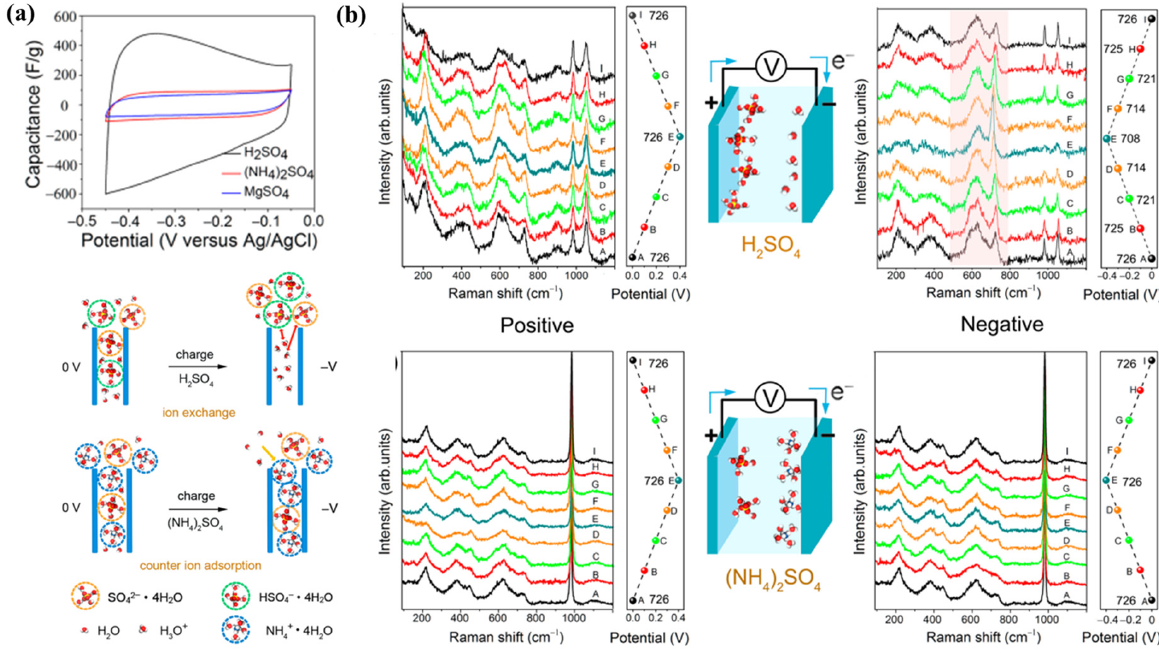
Figure 22. ( a ) CV-curves ( b ) In situ Raman spectra of Ti 3 C 2 T x MXene recorded on a positive electrode and a negative electrode [152].